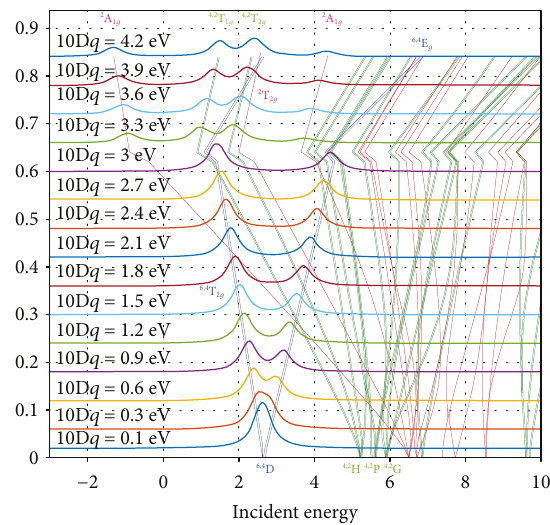
Figure 37: 2p XES projections of a calculated 1s2p RIXS spectrum for Mn 3+ (3d 4 ). Note the HS-LS transition at approximately 10D q ≈ 2 85eV . In fact, there are two HS → LS transitions, in the GS and in the IS, which are not necessarily occurring at the same 10D q value.